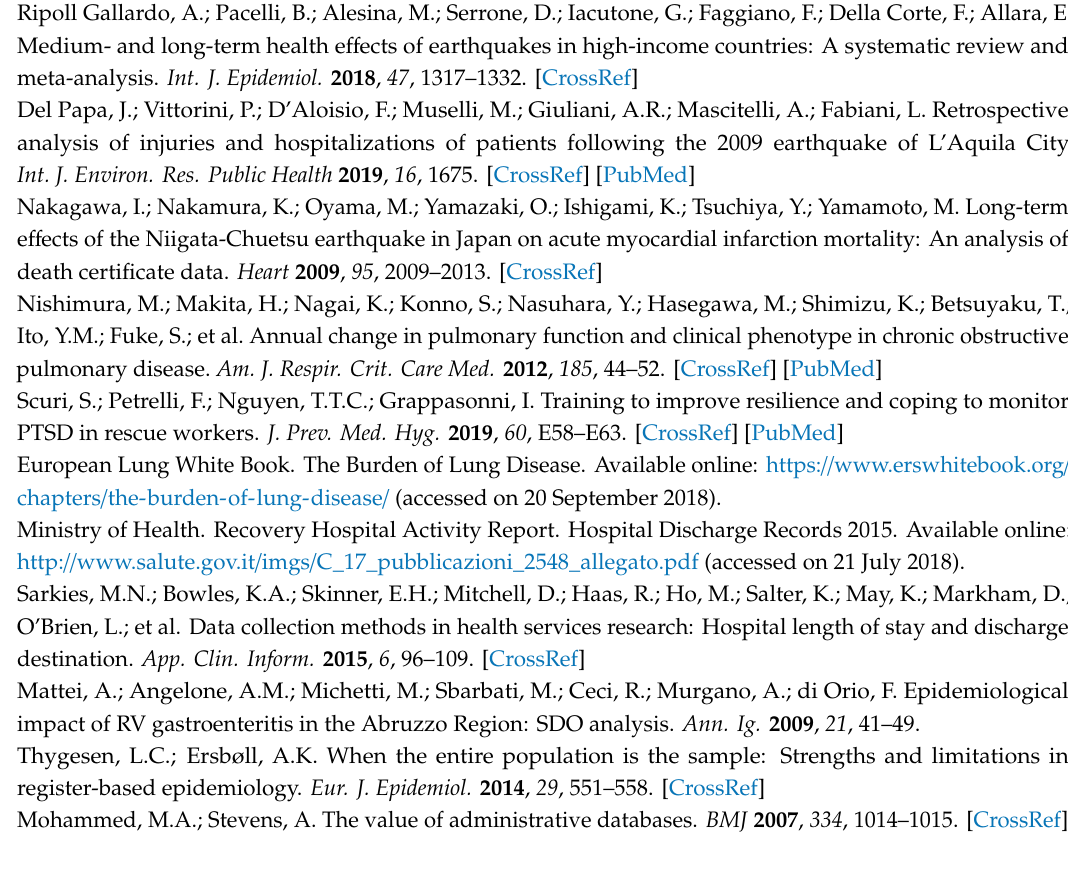
Figure S1: List of municipalities belonging to the Crater area, Table S1: ICD9-CM codes of respiratory disease subgroups, Table S2: Residents data in Abruzzo region in 2009, stratified by area, Table S3: Total number of hospitalizations for all causes by area and by year in Abruzzo region, Table S4: Total number of hospitalizations for respiratory diseases between 2009–2015, by area, Table S5: Total number of hospitalizations for respiratory diseases between 2009–2015 in Abruzzo, by